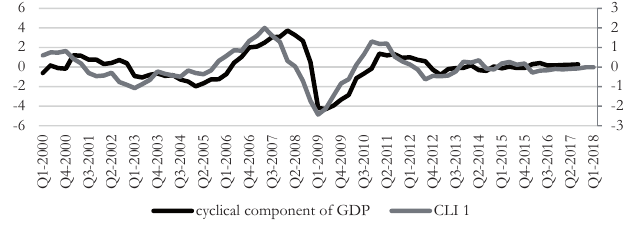
Fig. 4 – Graphical development of cyclical component of GDP Germany and forecasting CLI 1. Source: own